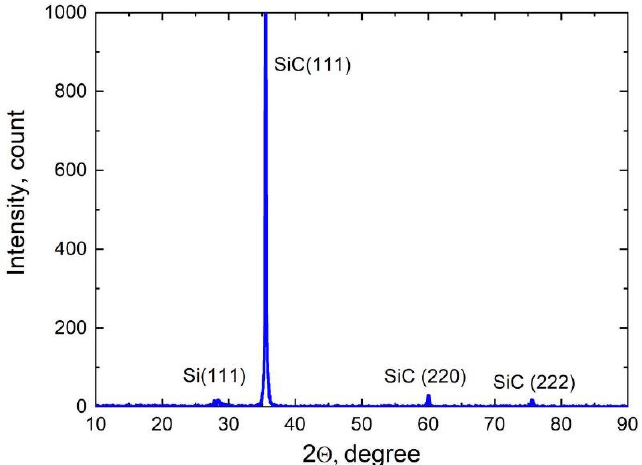
Figure 5. XRD pattern of the 3C-SiC/Si(111) sample produced at t a = 25 min. The Raman spectrum of the same sample obtained by confocal raman microscope WiTec Alpha300R, Ulm, Germany is shown in Figure 6. As the sample has already started to delaminate, there is no silicon line. In addition to the two peaks TO and LO of the 3C-SiC, there is an additional peak at 952 cm −1 which we associate with the silicon vacancies that have transited to a stable state denoted as C 4 V. The DFT modeling has shown that it is exactly the oscillation frequency of the C–C bonds arising in the 3C-SiC when a C atom jumps over to the place of the silicon vacancy [18]. Previously, by different research teams, this line was repeatedly observed in the infrared spectra (both transmission and reflection, which is much more sensitive than the Raman spectroscopy) of the 3C-SiC samples produced by the MCSA but with a significantly lower concentration of vacancies [19].